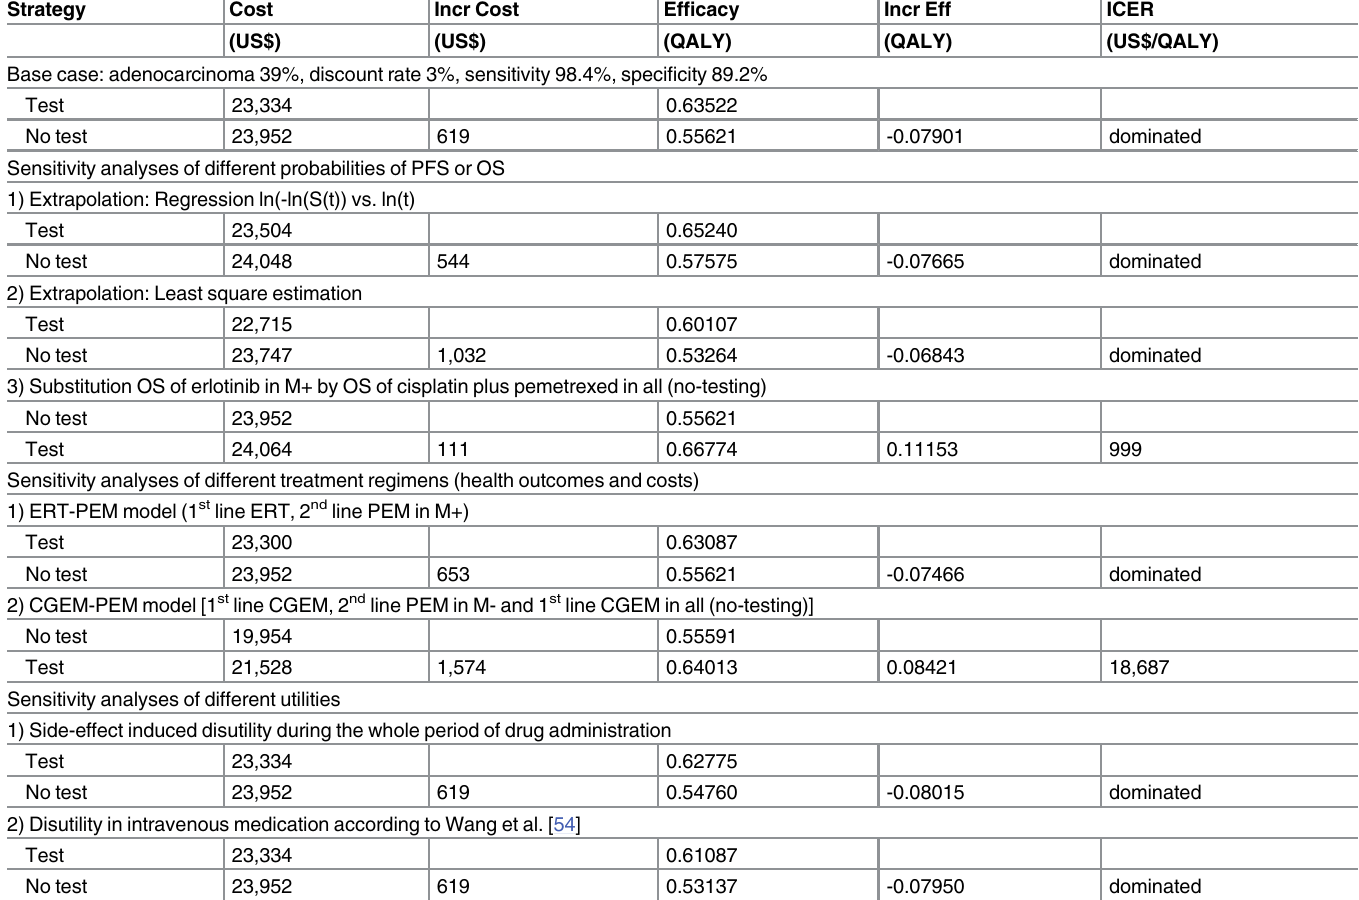
Table 2. Results of cost-effectiveness in the base case and sensitivity analyses.